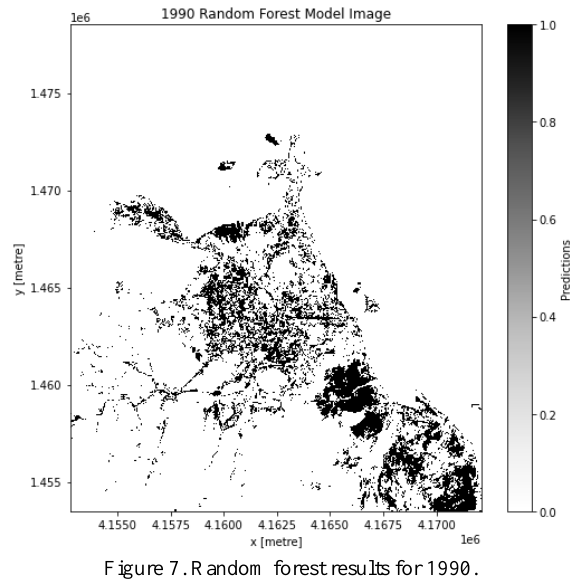
Figure 7. Random forest results for 1990.